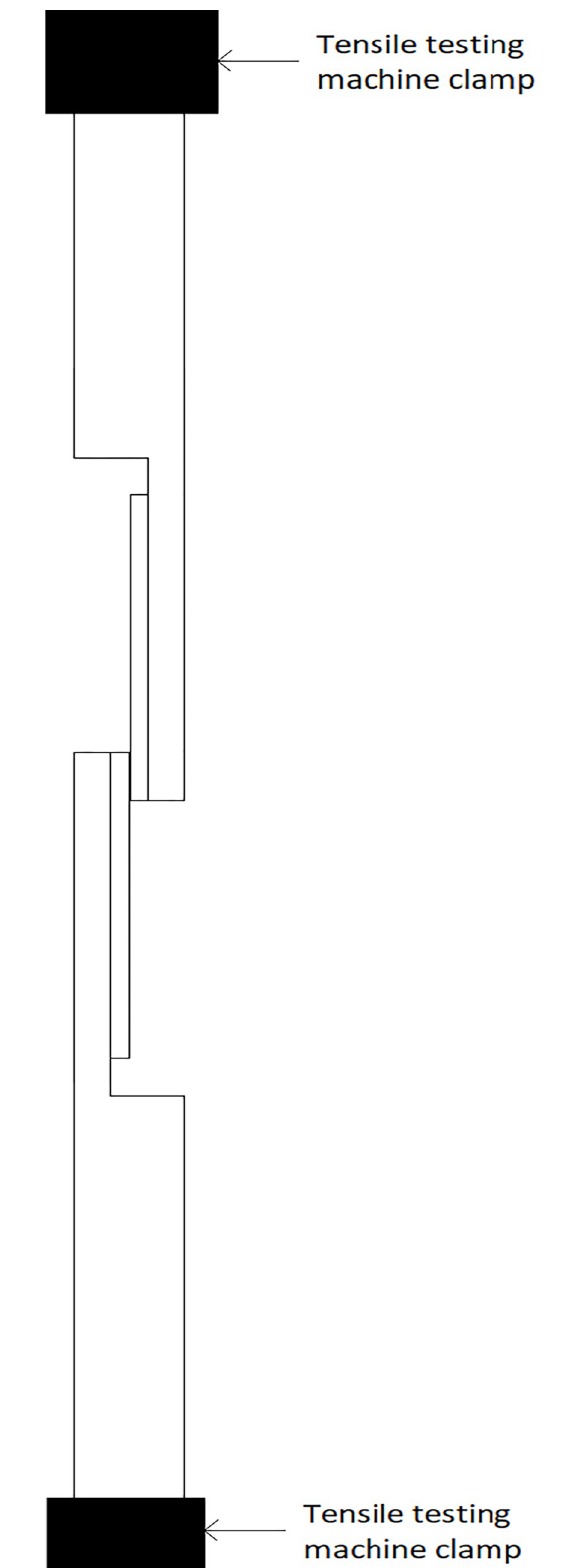
Fig 8. System for testing strength properties of tissue